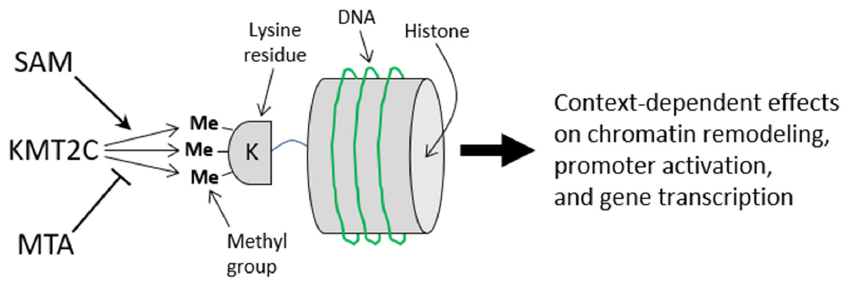
Figure 9. The interplay between SAM and MTA, regarding the activation of histone lysine methyl- transferase enzymes such as KMT2C. Under conditions with a high SAM:SAH ratio, SAM will occupy the methyltransferase domain of KMT2C and promote methyltransferase activity toward concentration, MTA will inhibit the methyltransferase domain of KMT2C and reduce the methylation of H3K4. In this example, the interplay between SAM and MTA influences the degree to which H3K4 is methylated. Ultimately, the degree of H3K4 methylation will have a large influence on chromatin remodeling. The architecture of the chromatin will then inform how transcription factors, enhancers, and coactivators can bind to DNA consensus sequences and to nearby proteins. In turn, this will guide gene promoter activation and gene